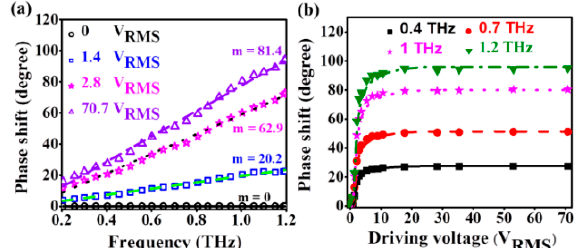
Figure 7. Phase shift properties as a function of ( a ) frequency for several values of applied voltage and ( b ) applied voltage at selected frequencies for a Mixture-250 TN-LC-based THz phase shifter. The slope of the linear line fitting experimental data is denoted by m. The circles, squares, diamonds, and triangles are experimental data. The solid line, dash line, dot line, and dash–dot line are ( a ) linear fit and ( b ) theoretical curves.